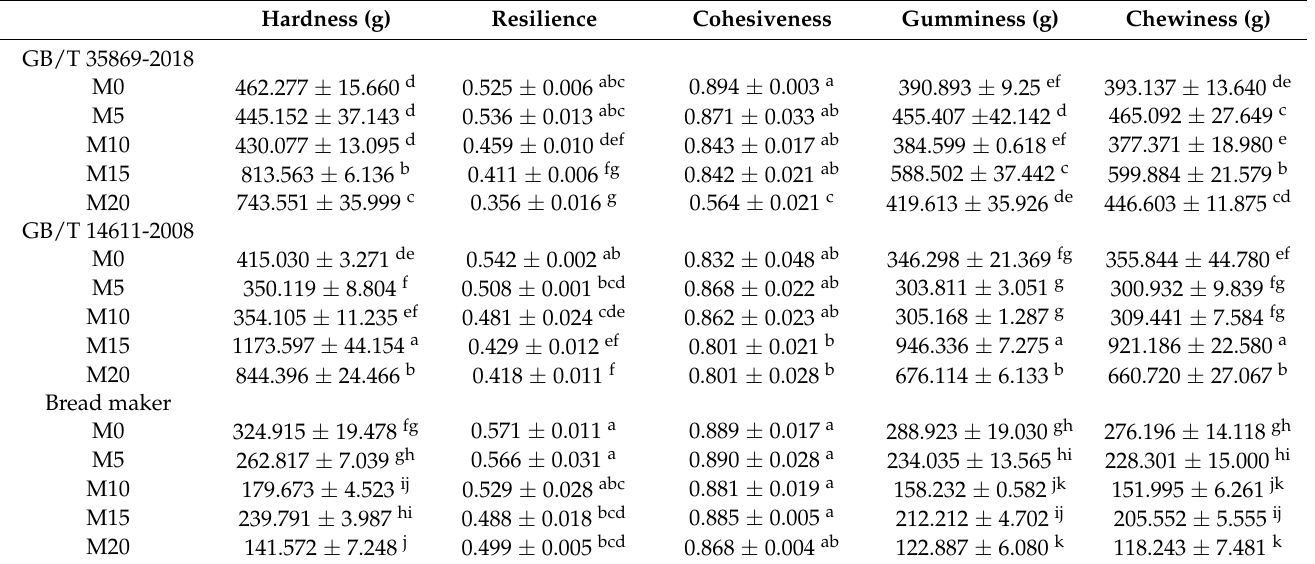
Table 6. Texture parameters of the bread with various mealworm powder substitution